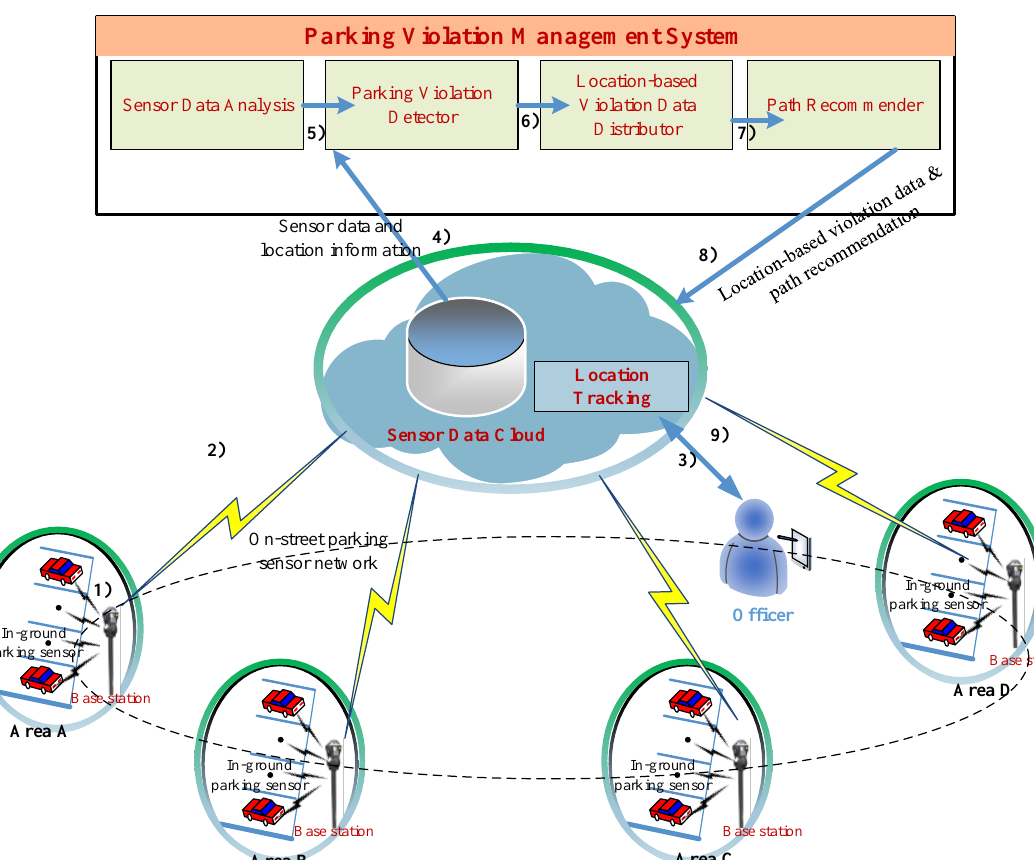
Figure 10. Architectural model of the proposed parking violation management